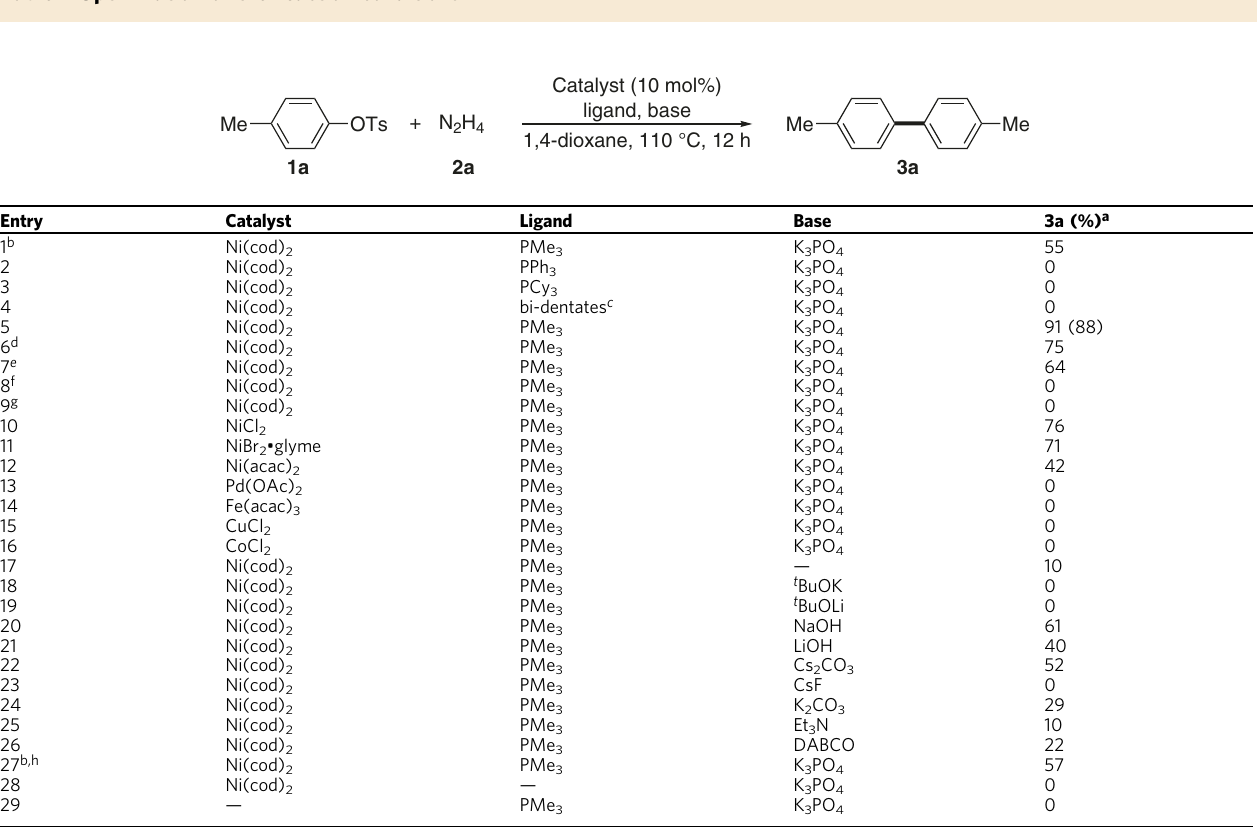
Table 1 Optimization of the reaction conditions